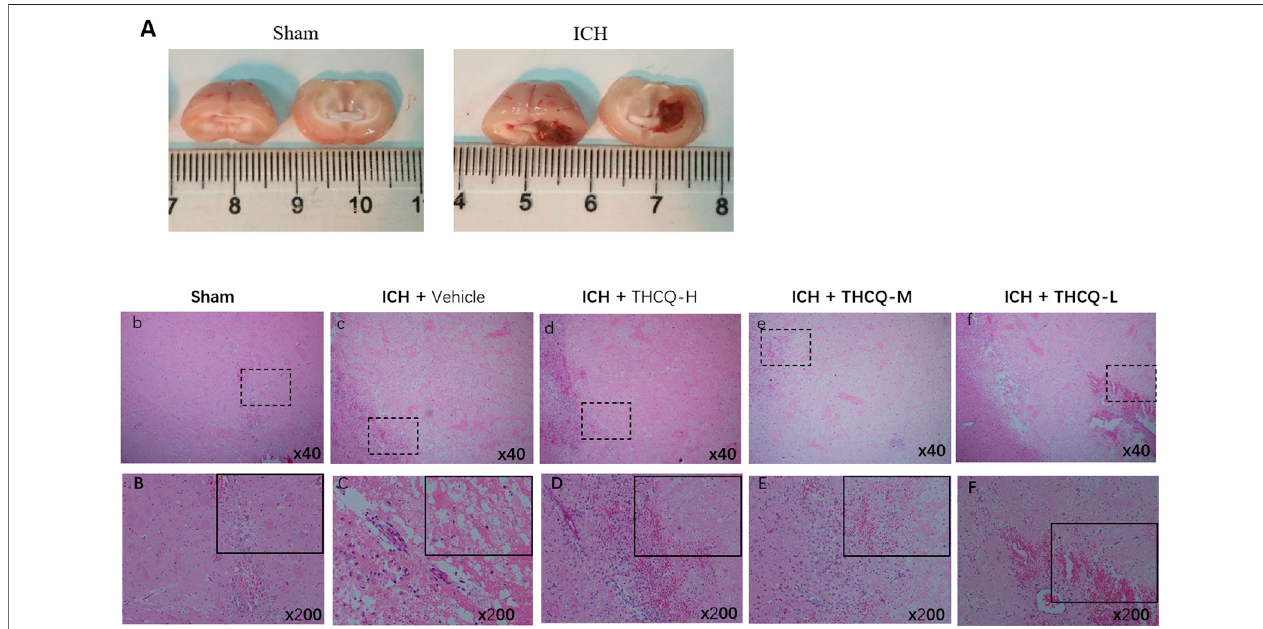
FIGURE 3 | Effects ofTHCQoncollagenase-inducedICH. SD ratswere challengedbyrightstriatum injection of4 μ gcollagenase.Braintissues were collected72 h afterchallengewithcollagenase.Typicalmacrographs(left:sham,72 hafteroperation;right:72 hafterICHinduction) (A) .Normalcerebralstriatum (b,B) andstriatum72 h aftercollagenaseinjection,showing in fi ltrationofin fl ammatorycells (c, C) , ICH+THCQ-L(28.2 mg · kg − 1 ) (d,D) , ICH+ THCQ-M(56.4 mg · kg − 1 ) (e,E) and ICH+ THCQ-H (112.7 mg · kg − 1 ) (f, F) . The histological morphology and pathology results showed that treatment with THCQ alleviated ICH-induced pathological changes.